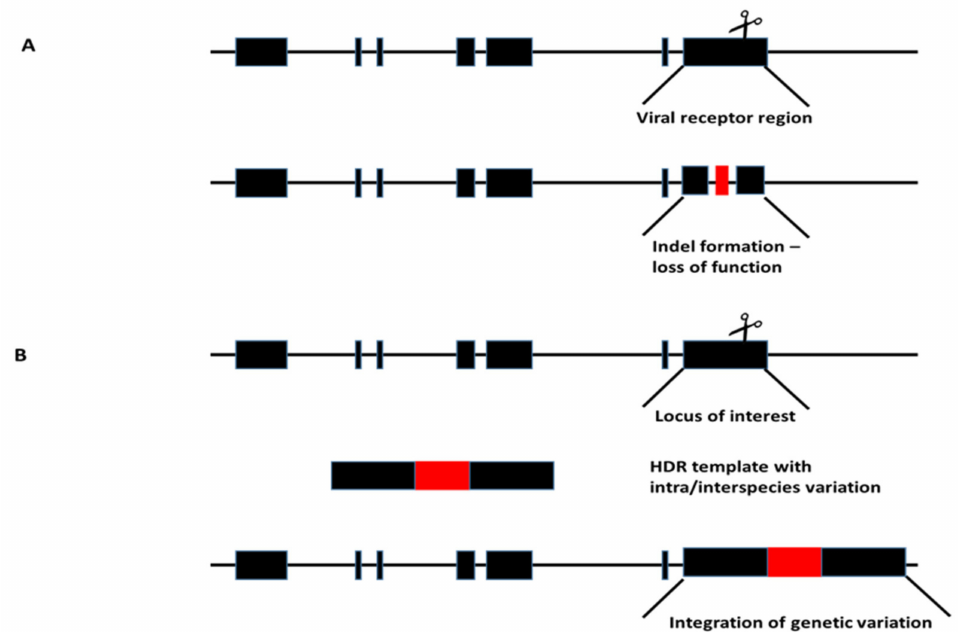
Figure 3. Targeting loci of interest: ( A ) Previously identified receptors susceptible to viral infec- tion could be targeted with genome editors, thereby inducing loss of function. ( B ) Identified in- ter/intraspecies variations responsible for viral susceptibility can be inserted in the locus of interest by homology-directed repair